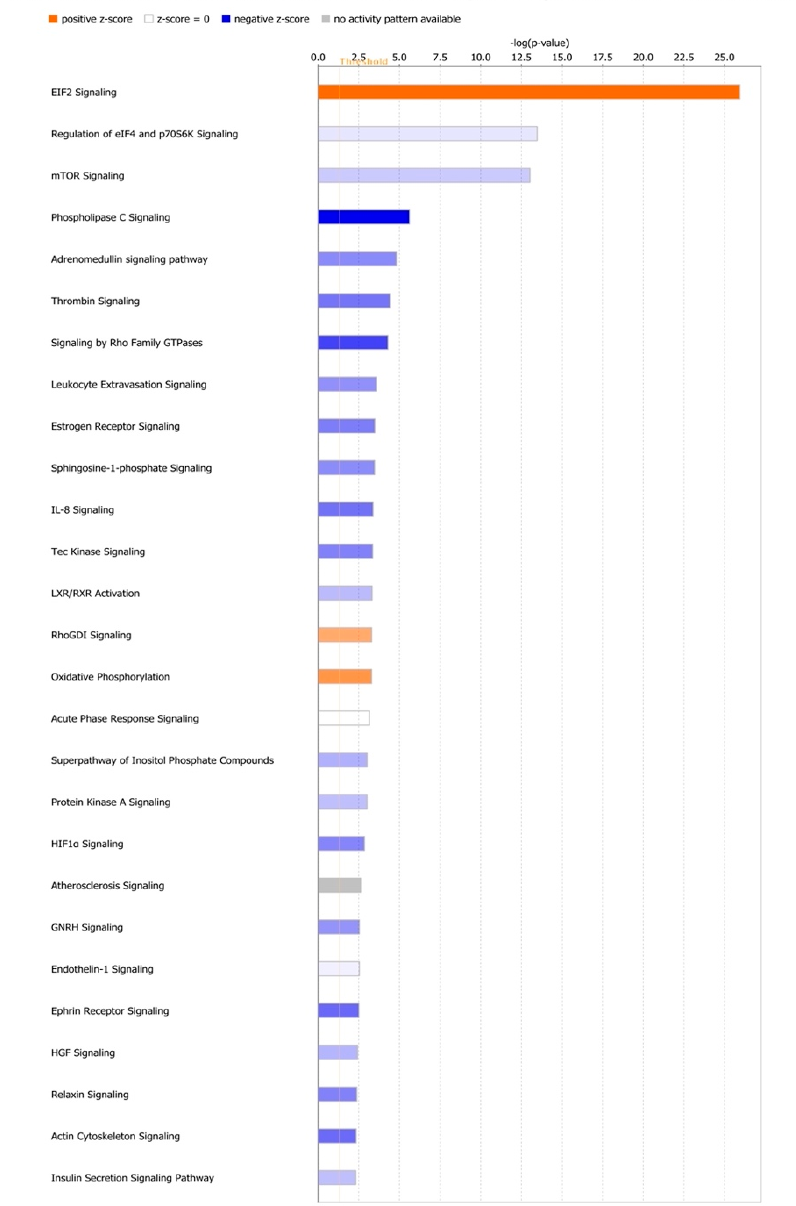
Figure 4. Top canonical pathways enriched in adipose tissue following treatment with ACTH. Pathways were ranked according to − log ( p value). The predicted activity pattern of each given pathway after ACTH treatment is indicated by color (as defined in figure legend) and follows the calculated Z -score: positive Z -score indicates activation while negative Z -score relates to predicted deactivation of canonical pathway. Canonical pathways considered not related to the analyzed tissue or treatment were removed. All DEGs ( p and FDR < 0.01) were used in the present analysis. List of selected canonical pathways, statistical details and representative genes included on each pathway are described in Supplemental File S2.